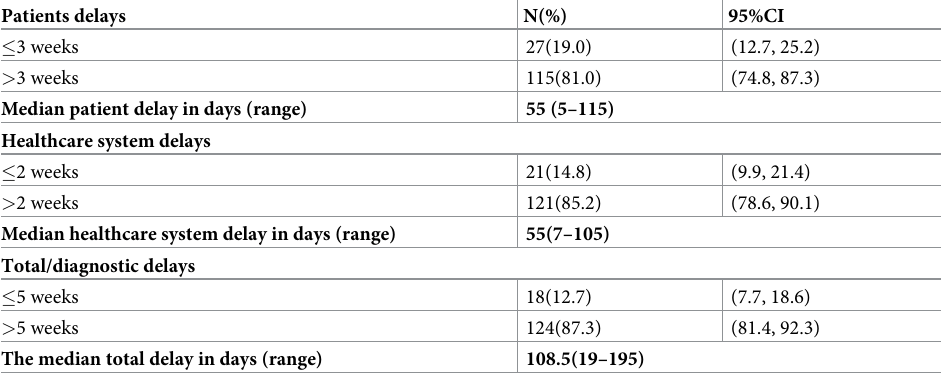
Table 4. Delay status of EPTB patients at public health facilities of North Shewa zone, Ethiopia, April